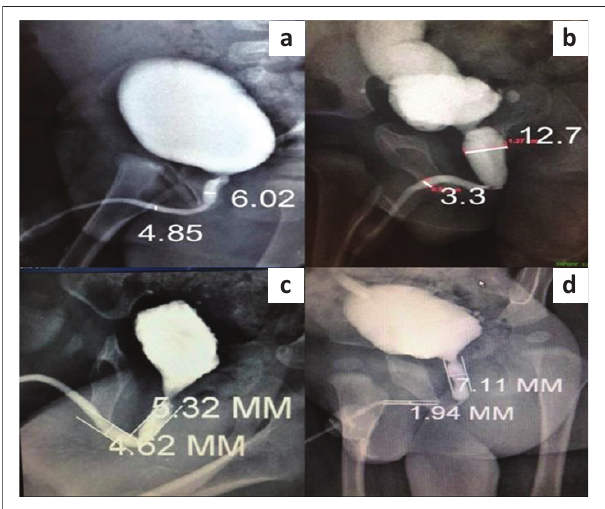
FIGURE 1: On voiding cystourethrogram (VCU) the posterior urethra:anterior urethra ratio (PAR) was computed by dividing the maximum posterior urethral diameter by the anterior urethral diameter (in mm). Distances were measured by an on-screen distance measurement tool in the radiology department, to avoid error. (a) Normal voiding cystourethrogram – control: PAR = 6.02/4.85 = 1.24; (b) posterior urethral valve (PUV) at the time of diagnosis: PAR = 12.7/3.3 = 3.84; (c) successful PUV ablation: PAR = 5.32/4.62 = 1.15; (d) persistent obstruction because of a stricture or residual valve: PAR = 7.11/1.94 = 3.66.